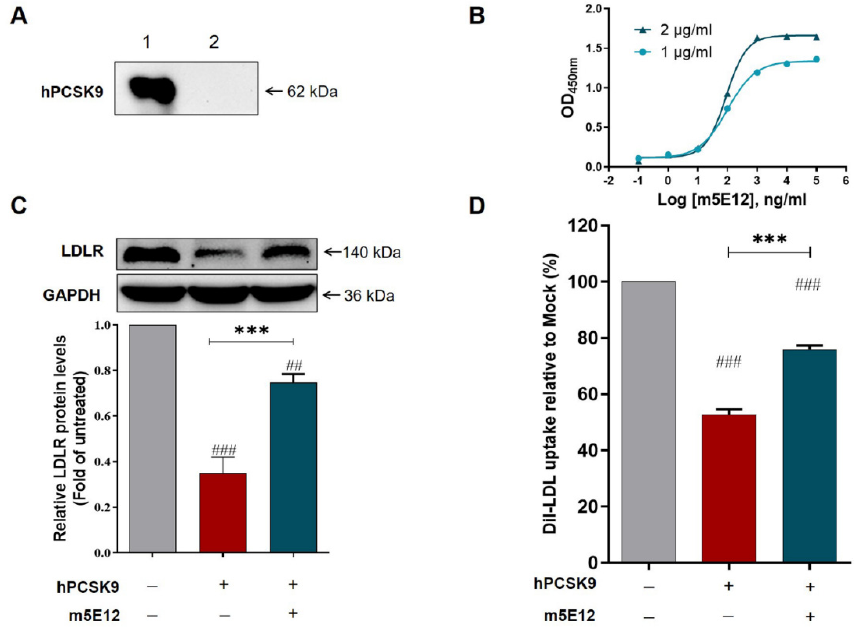
Figure 2. Characterization of mAb 5E12. ( A ) Western blot analysis revealed that the hPCSK9 protein (lane 1) is specifically recognized by mAb 5E12. The solvent vehicle of hPCSK9 protein (PBS buffer) was served as a negative control (lane 2). ( B ) Nonparametric test fitting curve of the results of non- competitive ELISA. The EC 50 was equal to 81.36 ng/mL and 90.42 ng/mL when the concentrations of hPCSK9 protein were 1 µ g/mL and 2 µ g/mL, respectively, by which K aff could be calculated as 1.0 4 × 10 9 M − 1 , using the formula of K aff = (n − 1)/2(n[Ab’]t − [Ab]t). ( C ) Inhibitory effect of m5E12 on PCSK9-mediated LDLR degradation as assessed by Western blot analysis. HepG2 cells were treated with 20 µ g/mL hPCSK9 alone or co-treated with 50 µ g/mL m5E12 for 12 h, then the protein levels of LDLR were determined by Western blot. The changes of LDLR were calculated relative to that of the Mock group (vehicle control) after calibration with GAPDH in each lane. ( D ) Effect of m5E12 on PCSK9-mediated inhibition of LDL-C uptake in HepG2 cells. ## p < 0.01 and ### p < 0.001 vs. Mock group; *** p < 0.001 vs. hPCSK9 group. Data are means ± SEM of 3 independent